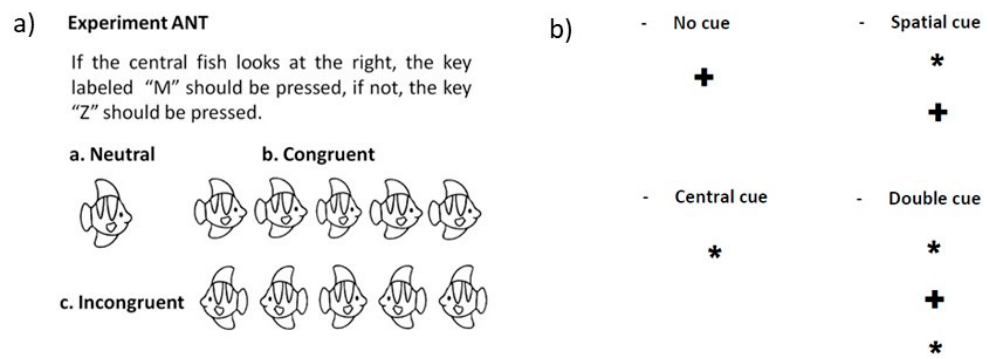
Figure 2. In panel ( a ), a visual example of the attention network task (ANT) carried out in this work is shown whereas in panel ( b ), the four cue conditions are included.